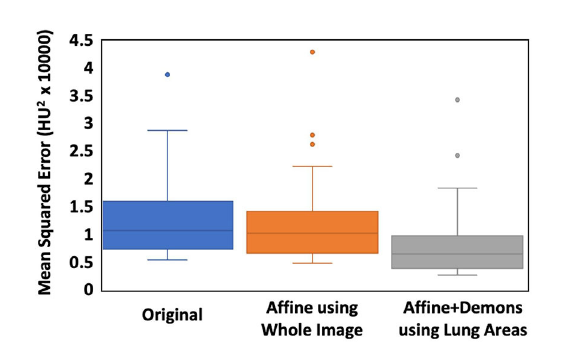
FIGURE5 The box plot of the MSE between the baseline and the first F/U images. The first column is the difference calculated using the original images. The second column is calculated after the Affine alignment, and the third column is after the completed Affine + Demons registration. The MSE is decreased after the Affine, and further decreased after the Demons registration, and the difference is significant using the Wilcoxon signed-rank test ( p <